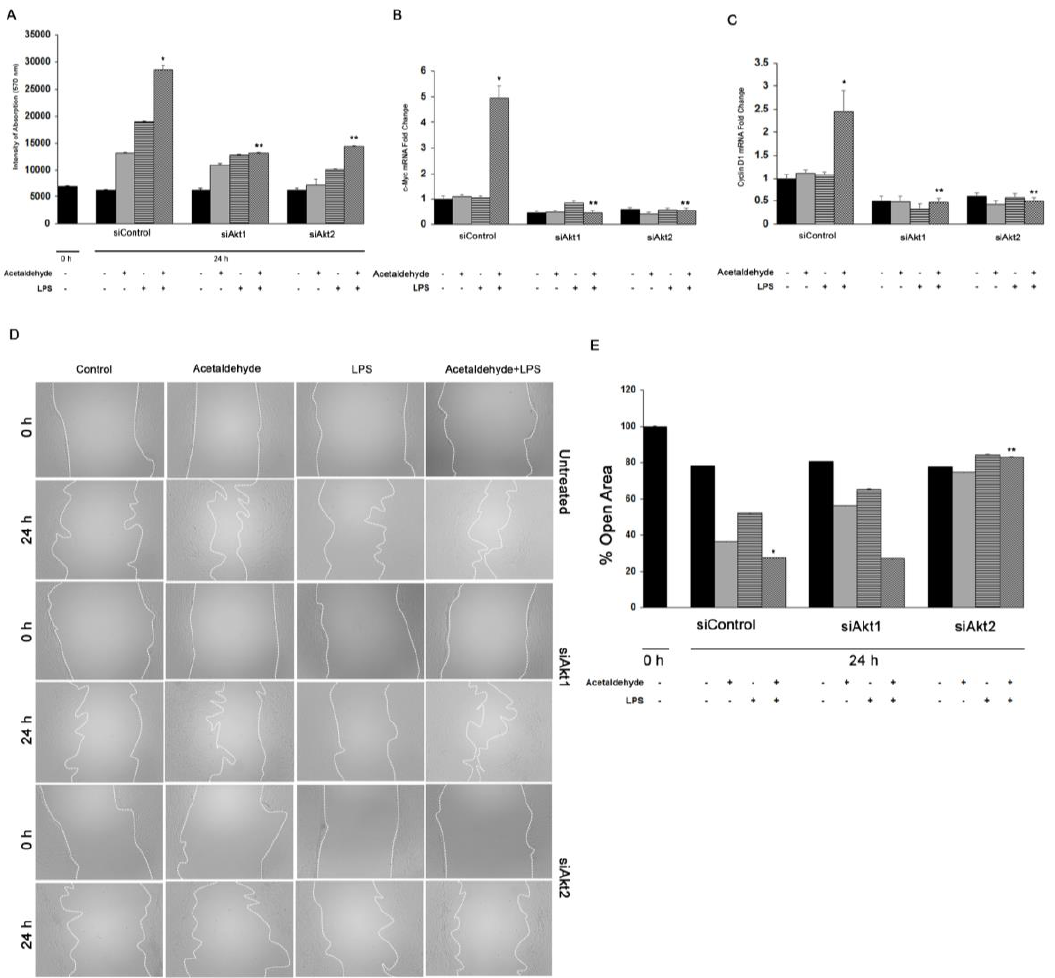
Figure 5. Role of Akt1 and Akt2 in HSC proliferation and migration. ( A ) Cell proliferation was performed by MTT assay of human HSC transfected with siAkt1 or siAkt2 and treated for 3 h with acetaldehyde, LPS, or both. Quantitative qPCR analysis of ( B ) c-Myc and ( C ) Cyclin D1 was performed with total RNA obtained from human HSCs. All values are means of triplicate experiments ± SE after correcting for the expression of S18 . ( D ) Cell migration was determined after wounding a confluent culture and measuring the gap area at the time points indicated in the figure. Panel E shows percent of open area. Values are means of triplicate experiments ± S.E. * p < 0.05 as compared to control, ** p < 0.05 as compared to acetaldehyde and LPS.